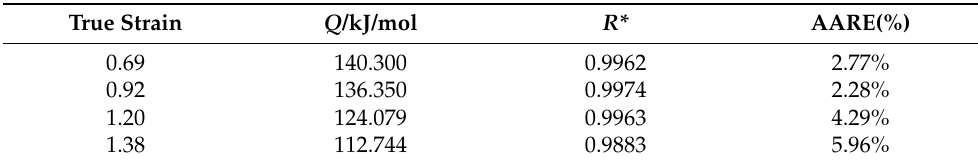
Table 3. Calculated values of R* and average absolute relative error (AARE) for constitutive equations with different stains.